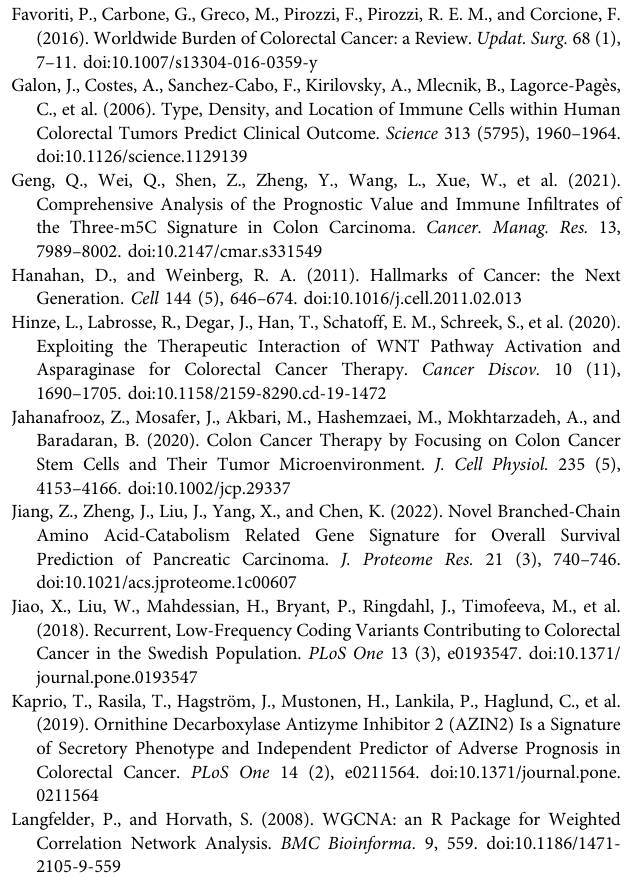
Supplementary Figure S1 | GO analysis and expression of nine genes in tumor and cancer tissues. (A) GO enrichment analysis of DEGs of the TCGA-COAD, revealing that amino acid metabolism partakes in COAD development. (B) The expression of the nine screened genes in tumor and healthy tissues showed a signi fi cant difference. Supplementary Figure S2 | The relationship between the risk score and clinical features and DCA plot of the nomogram. (A,B) The relationship between risk score and clinical characters. T, N, M, and stage were in positive correlation with the risk score. (C) DCA of the nomogram exhibited a robust nomogram. Supplementary Figure S3 | GO analysis in risk model and ESTIMATE along with the rainbow fi gure of CIBERSORT. (A) GO plot of the DEGs of risk groupings. (B) ESTIMATE of the risk model, which revealed a relatively meaningful outcome in ImmuneScore ( p = 0.057). (C) The distribution of immune cells in 399 samples. Supplementary Figure S4 | IC50 analysis were calculated. (A) Relationship betweenpaclitaxelandriskscore. (B) RelationshipbetweenShikoninandriskscore. SupplementaryTableS1| 1353GOanalysisbetweentumorandnormaltissuesof colon cancer in TCGA. SupplementaryTableS2| UnivariableandmultivariableCOXregressionsofamino acid metabolism-related genes. Nine genes were selected to construct the prognosticmodel (HR: hazardratio; HR.95L and HR.95H:95%con fi denceinterval). SupplementaryTableS3| 505GOpathwaysobtainedbetweenhigh-andlow-risk groups. Supplementary TableS4 | 334KEGGpathways obtainedbetweenhigh-and low- risk groups. Supplementary Table S5 | 667 GSEA pathways obtained between high- and low- risk